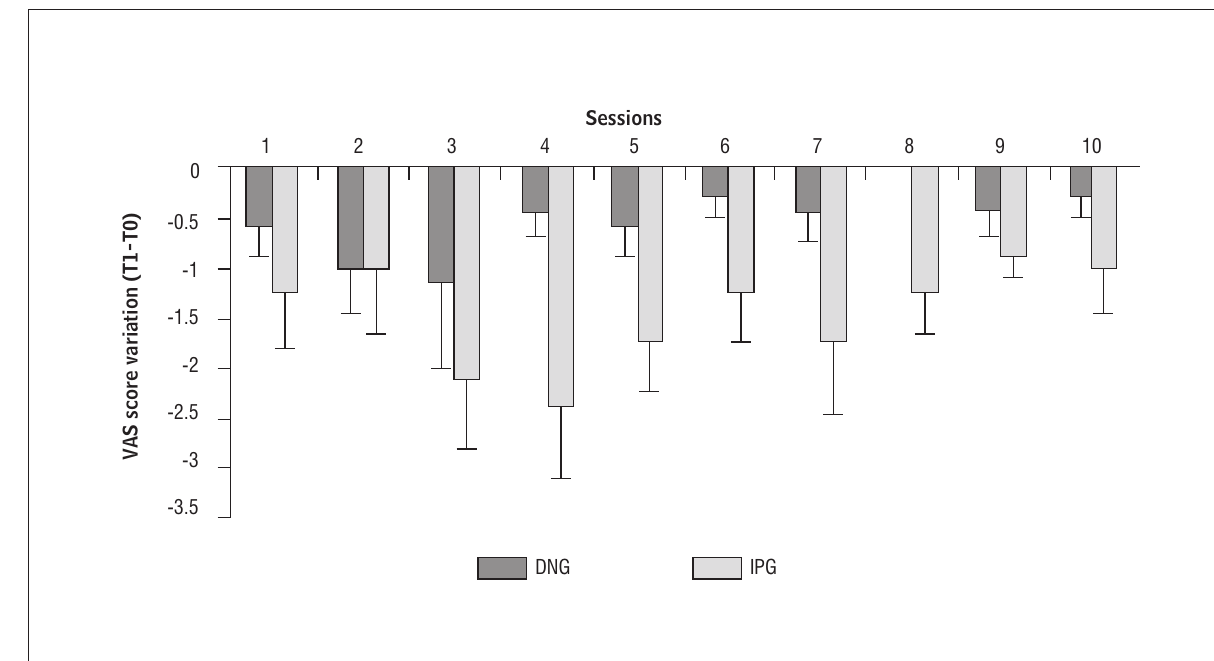
Figure 2 - VAS score variation during 10 therapeutics sessions in the the DNG underwent a dry needling and IPG underwent a ischemic pressure Error bar indicates standard error of mean (SEM). Paired sample-test